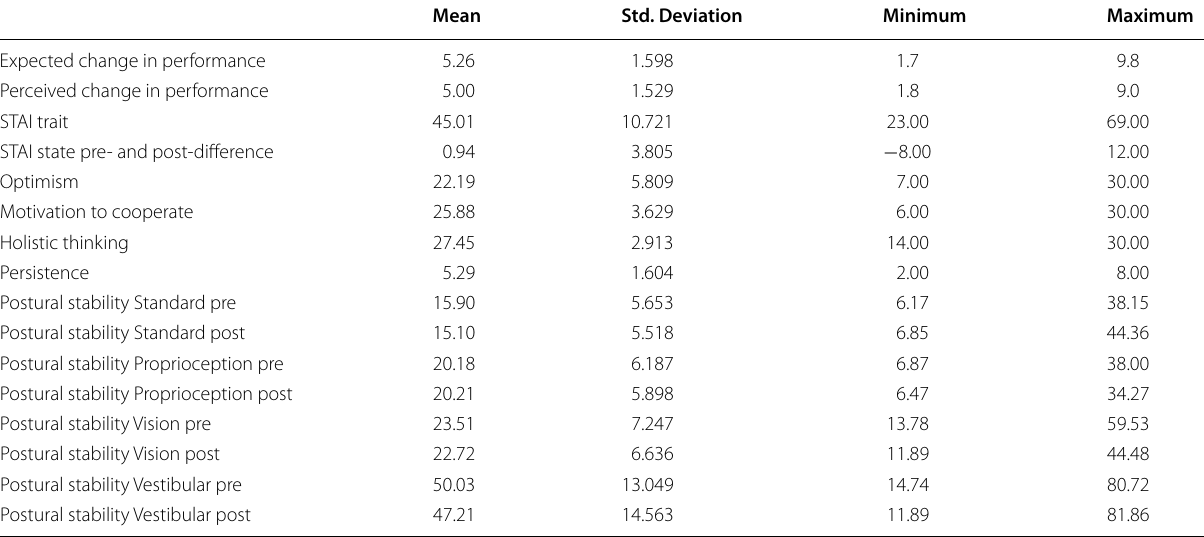
Table 1 Descriptive statistics of the investigated variables for all participants Mean Std.